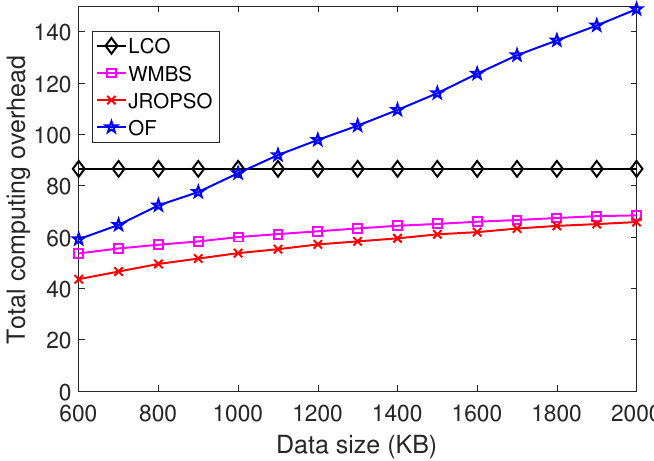
Figure 6. The effect of data size on task